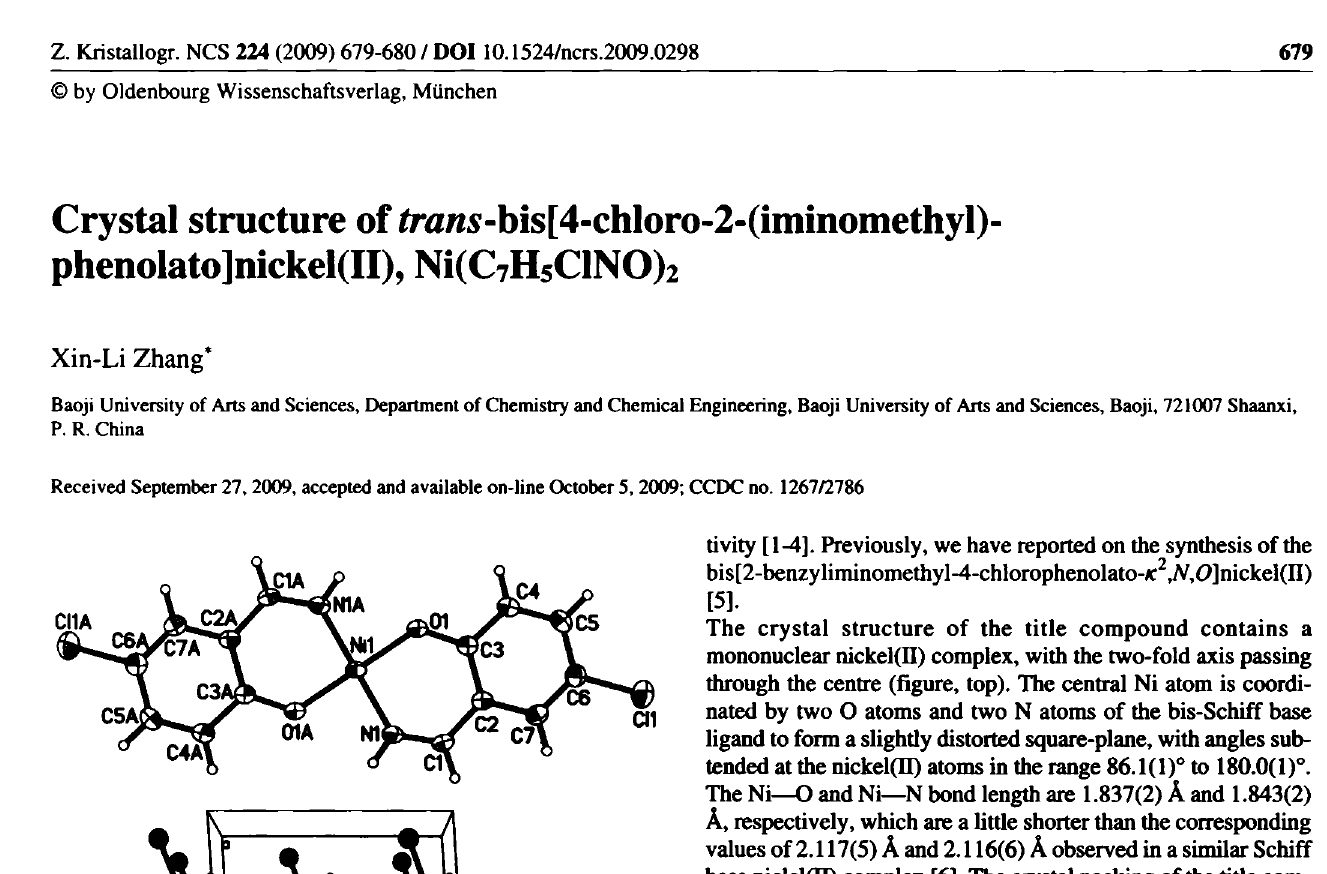
Table 1. Data collection and handling.